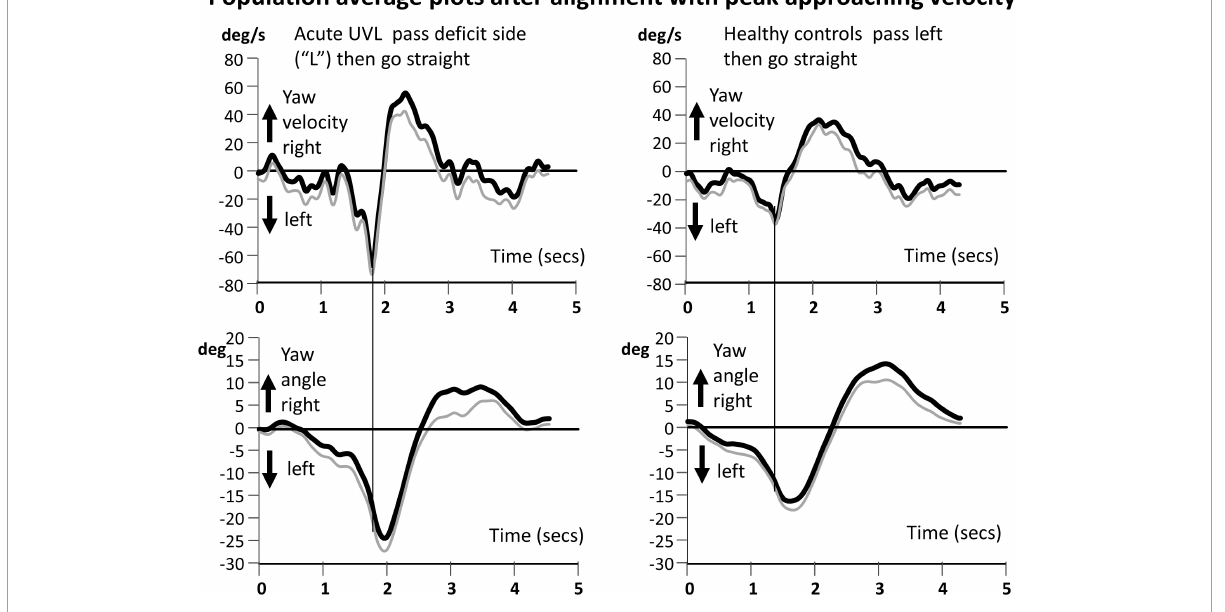
FIGURE3 Population yaw angular velocity and yaw angle average plots for the circumvention task of walking to the obstacle, passing it on the acute unilateral vestibular loss side, and then going straight (left traces are for aUVL patients). In the majority of cases, the deficit side was on the left. Therefore, the plots of healthy controls (right traces) are shown for passing the obstacle on the left. All traces have been aligned at the peak approaching yaw angular velocity prior to averaging. The population average traces have been filtered with a zero-phase shift second-order Butterworth filter with a cutoff at 5 Hz. The average peak angular velocity and the corresponding time on the yaw angle plots (lower traces) are marked by a vertical line. In each panel, the thick black trace is the mean trace (two repetitions of four subjects), and the thin gray line is the mean minus the standard error of the mean (SEM). Note the larger yaw velocities for the subjects with